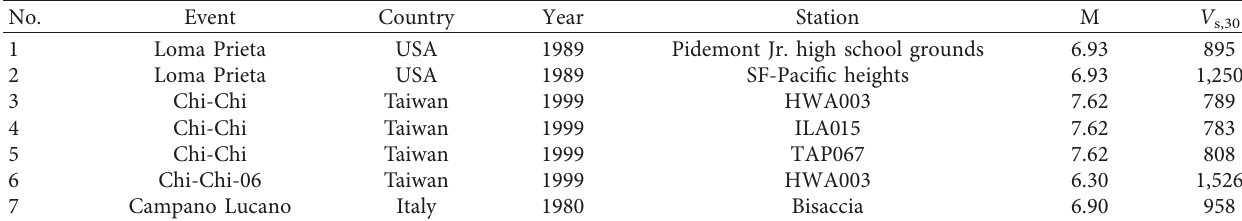
Table 7: Input bedrock earthquake records for selected 7 ground motions.